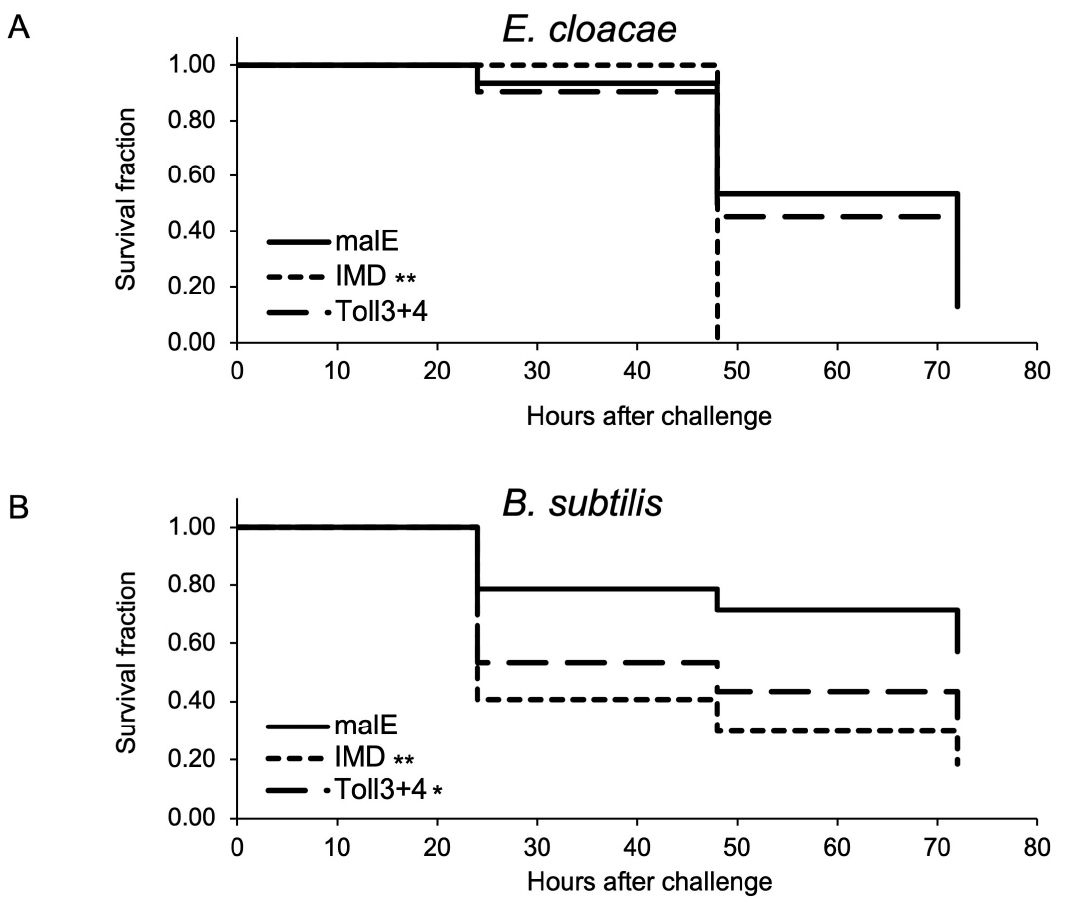
Figure 7. Effects of Toll3 and Toll4 double knockdown on host defenses against two model bacterial pathogens. On day 0, day-3 pupae pre-injected with the respective dsRNAs ( malE dsRNA-treated pupae and IMD dsRNA-treated pupae were used as controls) were challenged with E. cloacae ( A ) or B. subtilis ( B ), and the survival of the pupae was monitored and recorded every 24 h. Results are shown in Kaplan–Meier plots. Asterisks and double-asterisks indicate p < 0.05 and p < 0.01, respectively, according to the Gehan–Breslow–Wilcoxon